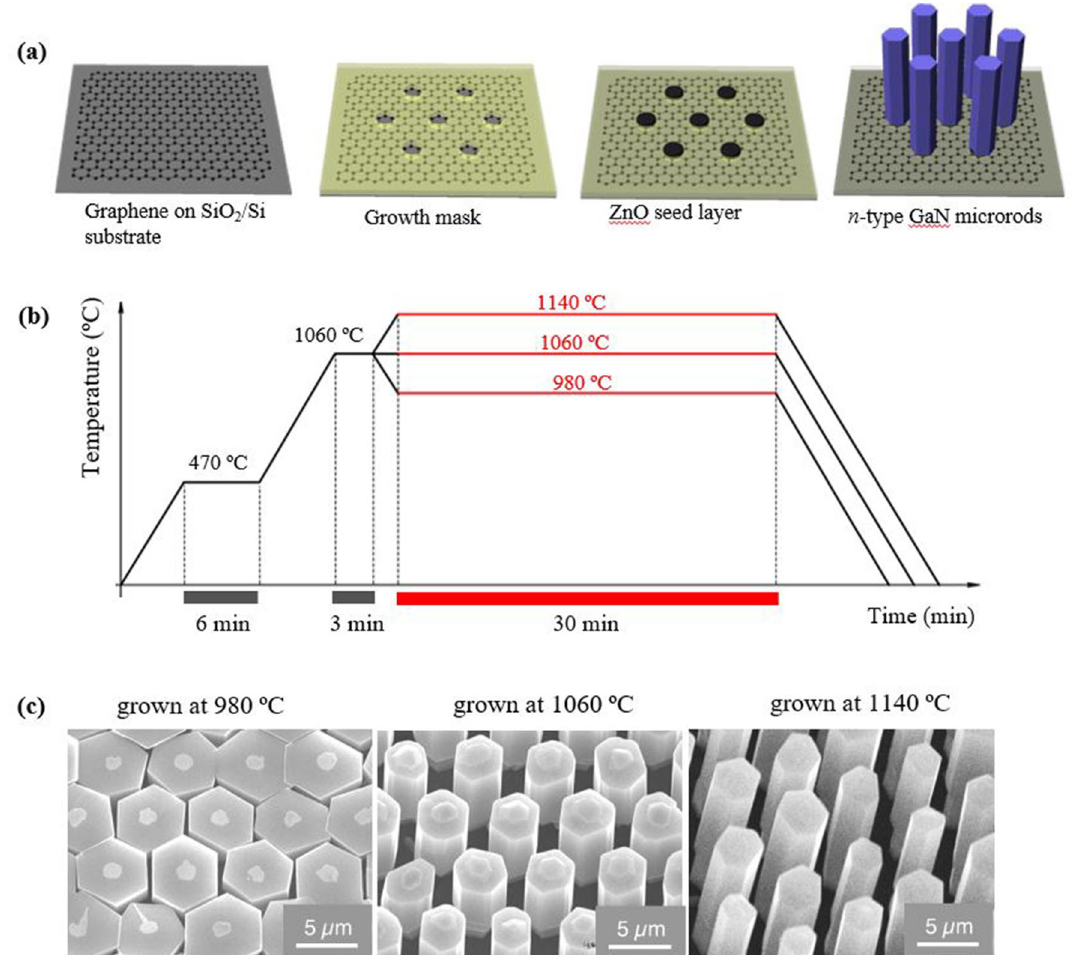
Figure 1. Dimension- and position-controlled growth of GaN microrod heterostructures. ( a ) Schematic illustration of GaN microrods growth on graphene films. ( b ) Graph of three-step growth method ( c ) SEM images grown at 980 °C, 1060 °C, and 1140